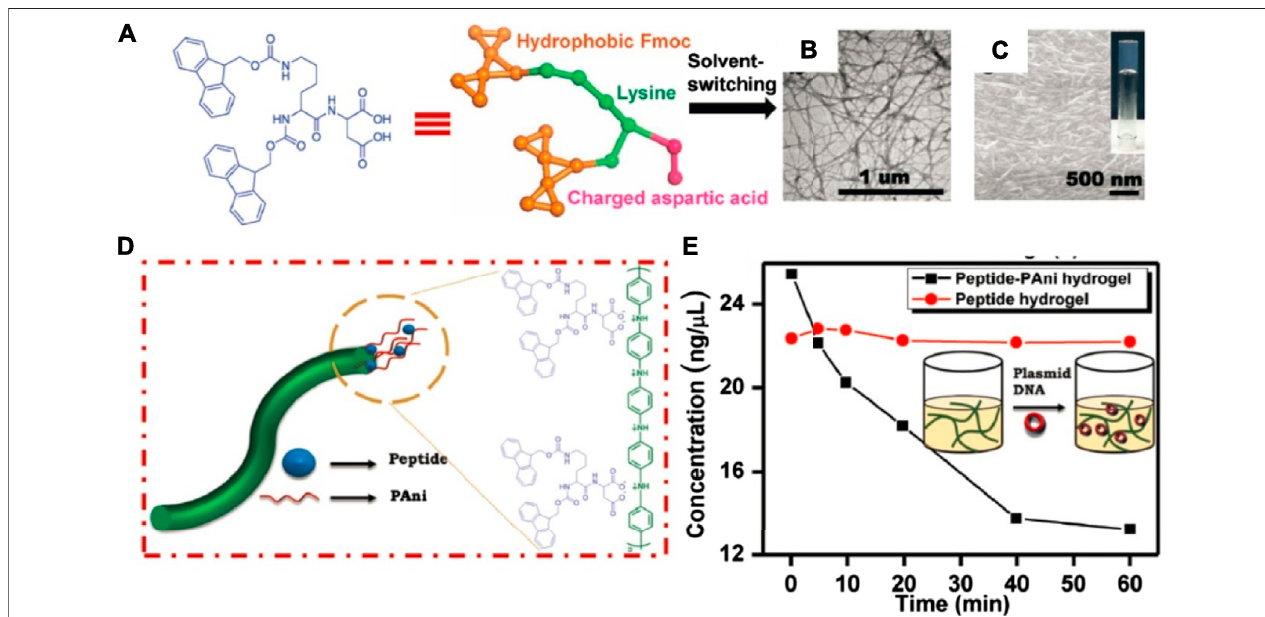
FIGURE 2 | (A) The structure of Fmoc-Lys (Fmoc)-Asp; (B, C) TEM and HRSEM images of Fmoc-Lys (Fmoc)-Asp hydrogels; (D) illustration of the probable structure of the peptide – polyaniline (PAni) formed fi bers; (E) DNA binding by the composite peptide – PAni hydrogel (Chakraborty et al.,